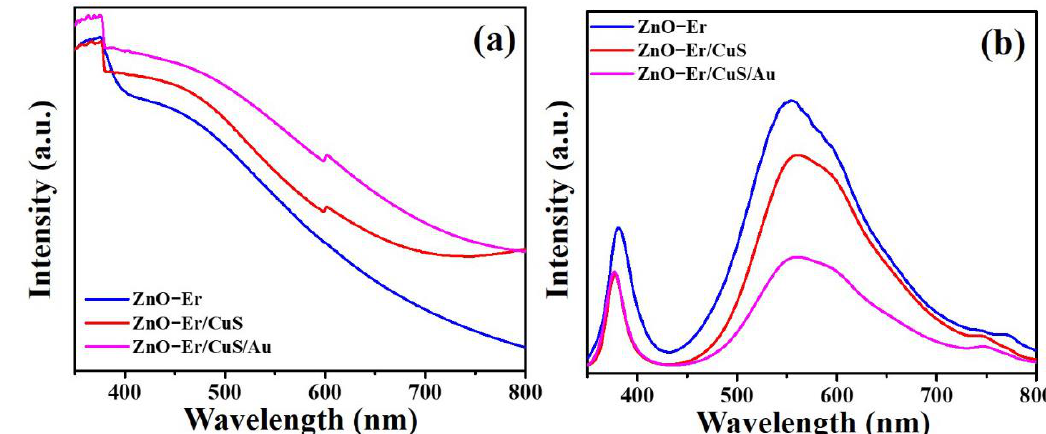
Figure 6. ( a ) UV-vis diffuse reflectance spectra and ( b ) PL spectra of Er-doped ZnO nanowires, Er-doped ZnO/CuS core- shell nanowires, and Er-doped ZnO/CuS/Au core-shell nanowires.